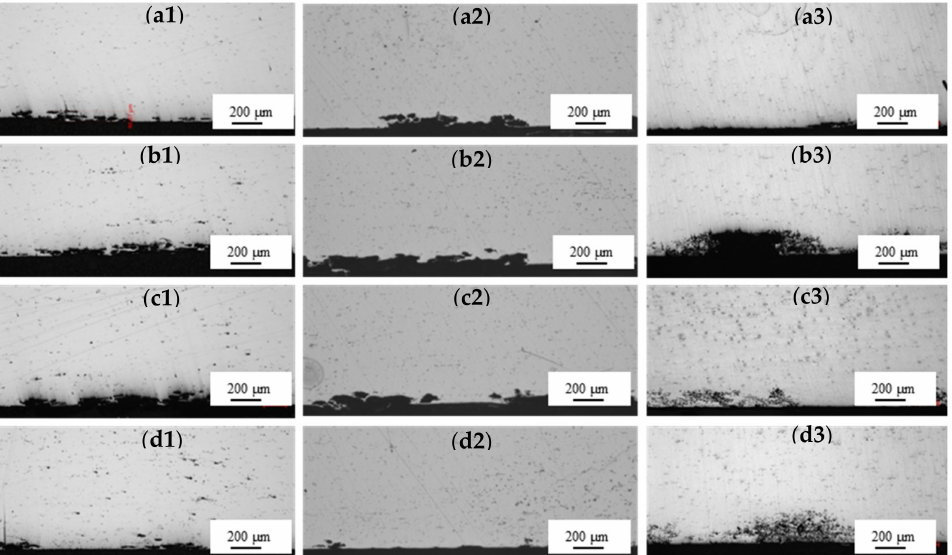
Figure 8. Metallographic cross sections showing localized corrosion morphologies with different alloy at different quenching transfer times ( a ) 2#-Cu/Mg = 1.47 (( a1 )—14 s; ( a2 )—30 s; ( a3 )—50 s), ( b ) 4#-Cu/Mg = 1.41 (( b1 )—14 s; ( b2 )—30 s; ( b3 )—50 s), ( c ) 6#-Cu/Mg = 1.09 (( c1 )—14 s; ( c2 )—30 s;